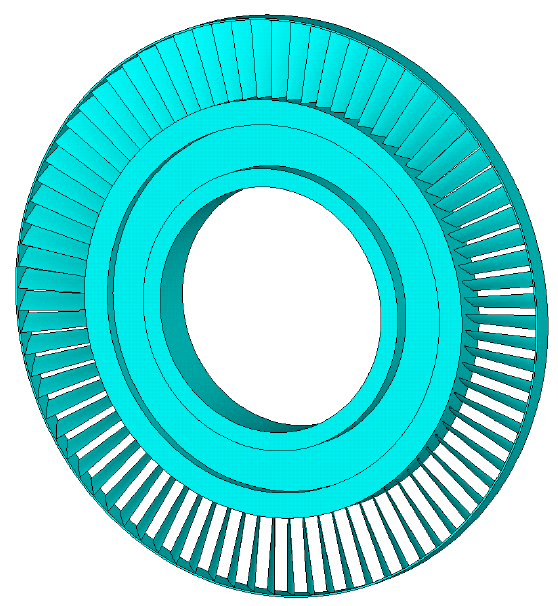
Figure 1. FE model of a bladed disk with shrouded blades.